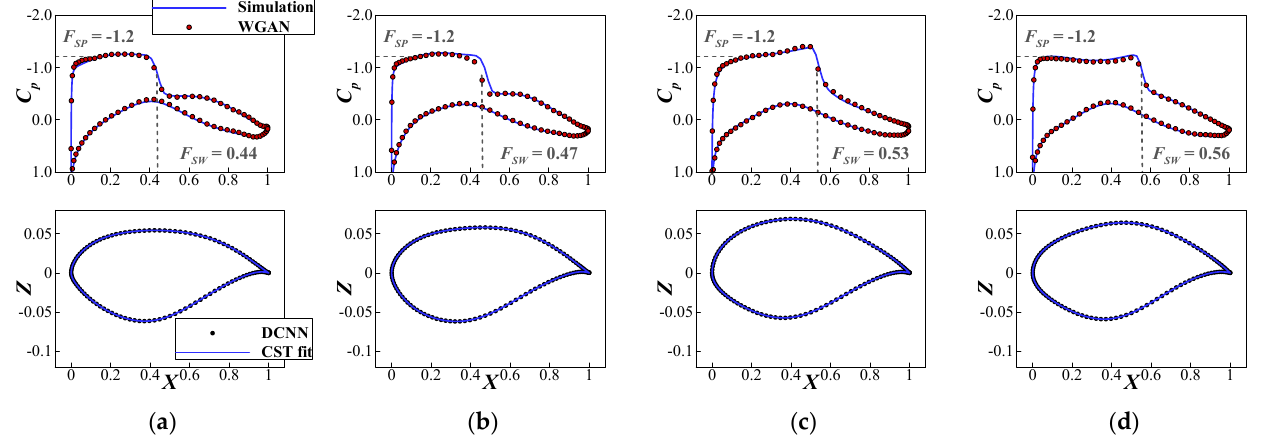
Figure 13. Typical inverse design results produced by different shock-wave position features: ( a ) F SP = − 1.2, F SW = 0.44; ( b ) F SP = − 1.2, F SW = 0.47; ( c ) F SP = − 1.2, F SW = 0.53; ( d ) F SP = − 1.2, F SW = 0.56.